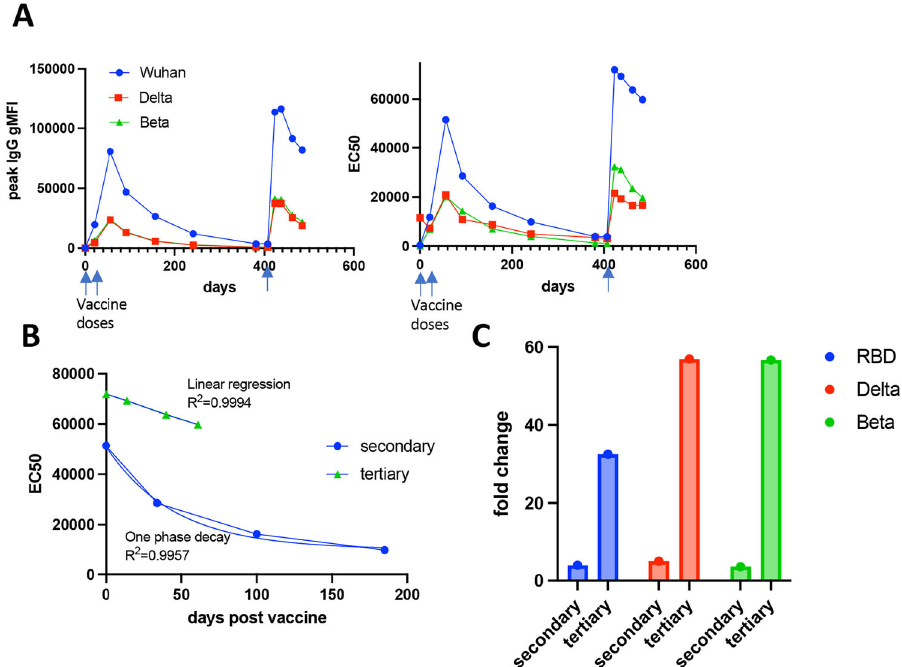
Fig. 4 Comparison between secondary and tertiary antibody response after third dose boost. A Wuhan, Delta, and Beta RBD-speci fi c IgG levels as measured by gMFI (left) or EC50 (right) after all vaccine doses indicated by the arrow. gMFI is shown from 1:2500 dilution of serum samples. B Decay of antibody levels (from EC50 in A ) in the days after the second (blue circles) or third vaccine dose (green triangles). Blue lines track one phase decay (for secondary) or linear (for tertiary) EC50 curve fi t. C Fold change in IgG against Wuhan, Delta and Beta as calculated using pre and post secondary immunization gMFI (secondary) and pre and post tertiary immunization gMFI